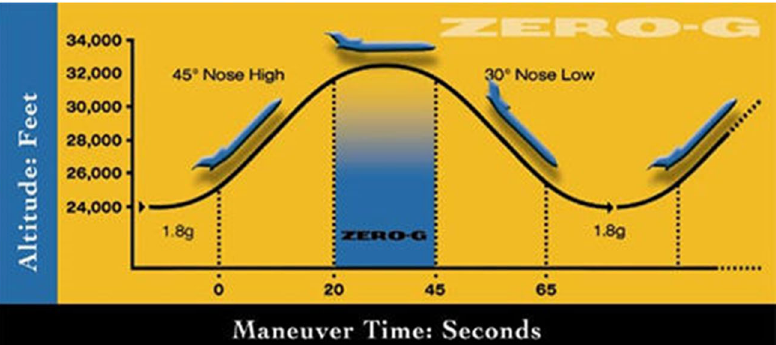
Fig. 7 Schematic of parabolic fl ight variable gravity levels versus time. The 25-s micro-g period is sandwiched by two high 1.8 g periods.